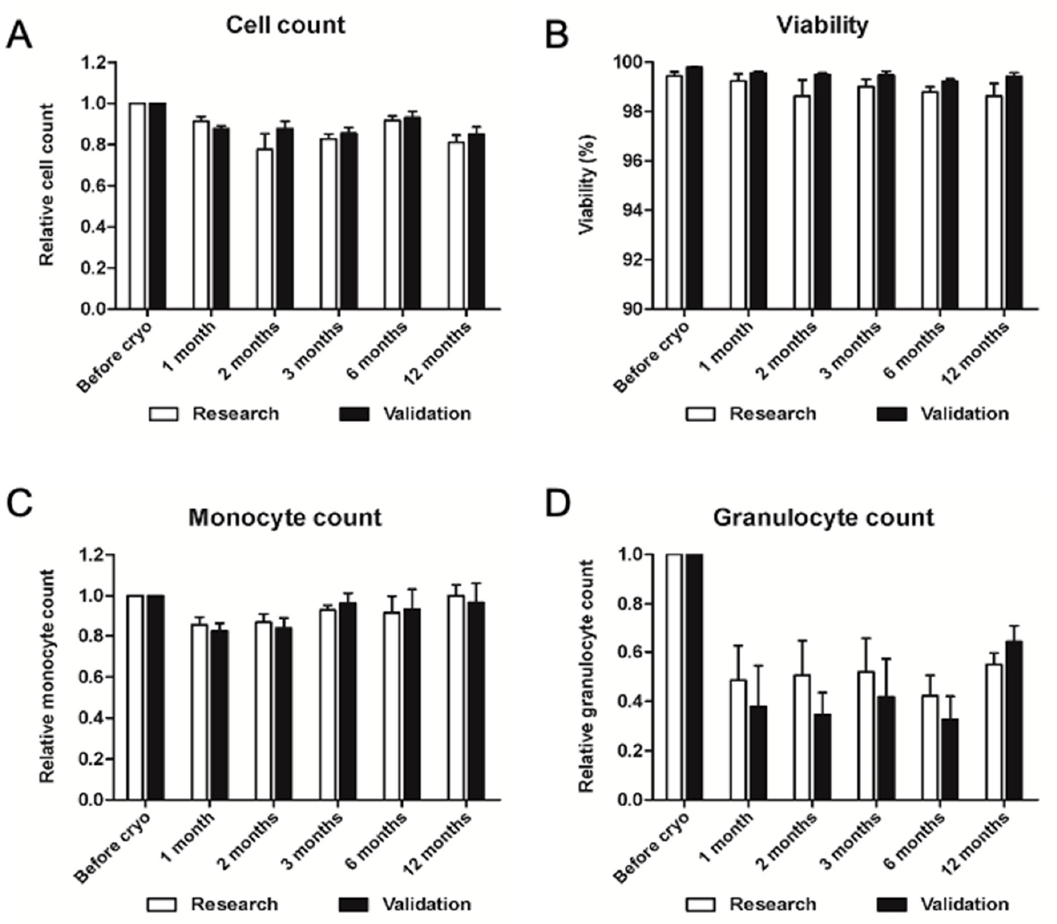
Figure 9. Validation of long-term storage of PBMC cryopreserved in nitrogen vapors ( ≤− 150 °C). Relative cell count ( A ), viability percentage ( B ), relative monocyte ( C ) and granulocyte count ( D ) of PBMC before cryopreservation and at T = 1, 2, 3, 6, 12 months. Relative values are normalized to control samples before freezing. Date are represented ad mean ±SEM, N = 3.